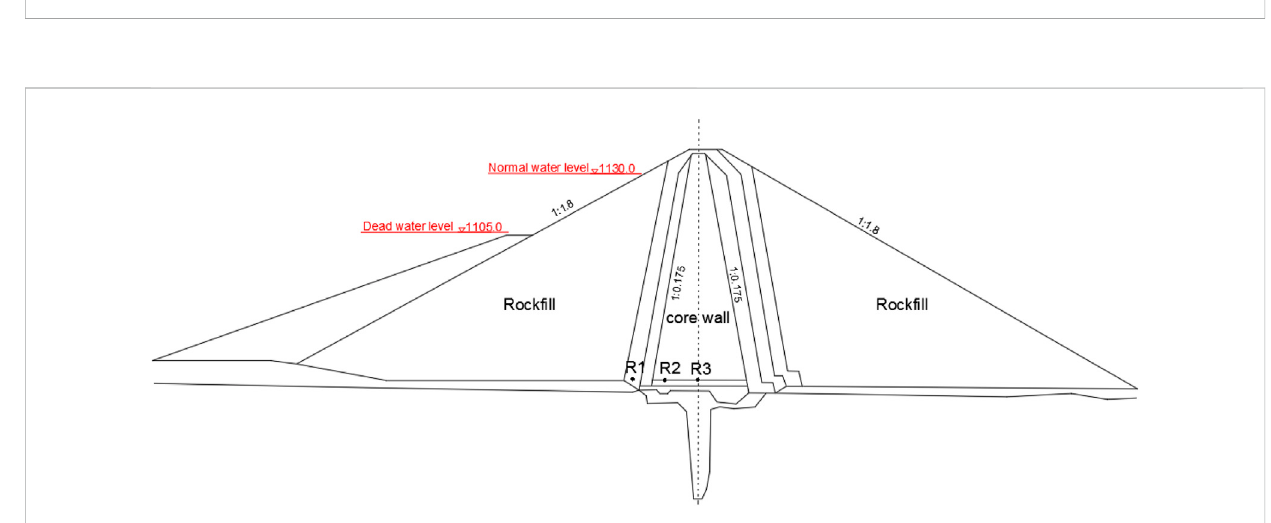
FIGURE 6 Measurement and predicted values from LSTM-M and MPM.